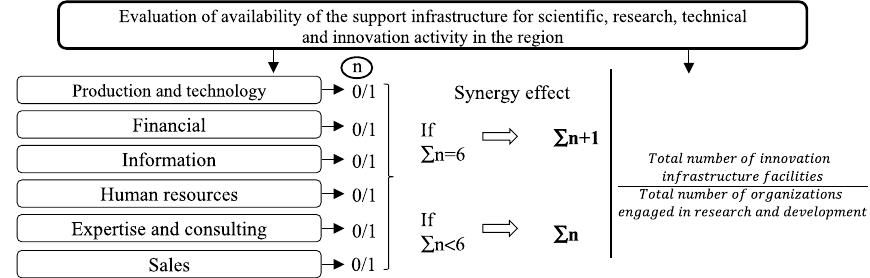
Fig. 2 Evaluation of availability of the support infrastructure for scientific, research, technical and innovation activity in the